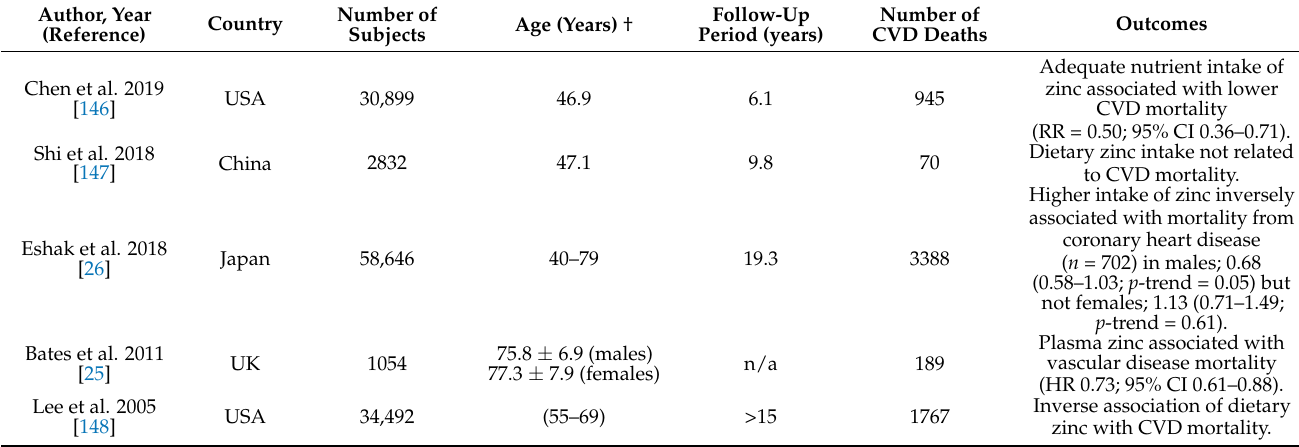
Table 3. Summary of observational studies regarding zinc intake and CVD